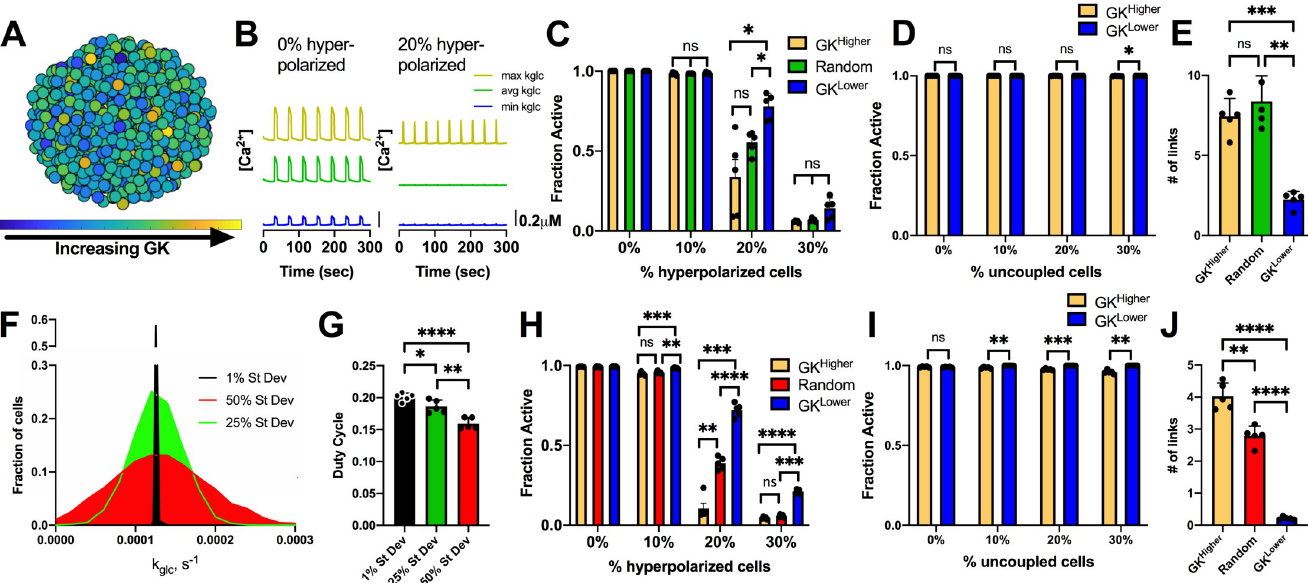
Fig 1. Simulations predicting how variation in GK activity impact islet function. A). Schematic of unimodal normal distribution of heterogeneous GK activity across simulated islet with 25% variation in GK rate (k glc ). B). Representative time courses of [Ca 2+ ] for 3 cells in simulated islet in A. Left is simulation with 0% hyperpolarized cells and right is simulation with a random 20% of cells hyperpolarized. Blue trace is cell with lowest GK rate (k glc ), Green is cell with the average GK rate, yellow is cell with the highest GK rate. C). Fraction of cells showing elevated [Ca 2+ ] activity (active cells) in simulated islets vs. the percentage of cells hyperpolarized in islet. Hyperpolarized cells are chosen based on their GK rate. D). Fraction of active cells in islet when cells are uncoupled from the rest of the cells in the simulation. E). # of links from network analysis of [Ca 2+ ] activity with GK 25% variation. F). Histogram showing average frequency of cells at varying GK rate (k glc ) for simulations that have different standard deviation in GK activity. G). Average duty cycle of cells from simulations with different standard deviation in GK activity. H). As in C. for simulations with standard deviation in GK activity at 50% of the mean. I). As in D. for simulations with standard deviation in GK activity at 50% of the mean. J). As in E but for simulations with GK 50% variation. Error bars are mean ± s.e.m. Repeated measures one-way ANOVA with Tukey post-hoc analysis was performed for simulations in C and G, Student’s paired t-test was performed for D and H, and one-way ANOVA was performed for F to test for significance. Significance values: ns indicates not significant (p > .05), � indicates significant difference (p < .05), �� indicates significant difference (p < .01), ��� indicates significant difference (p < .001), ���� indicates significant difference (p < .0001). Data representative of 5 simulations with differing random number seeds.